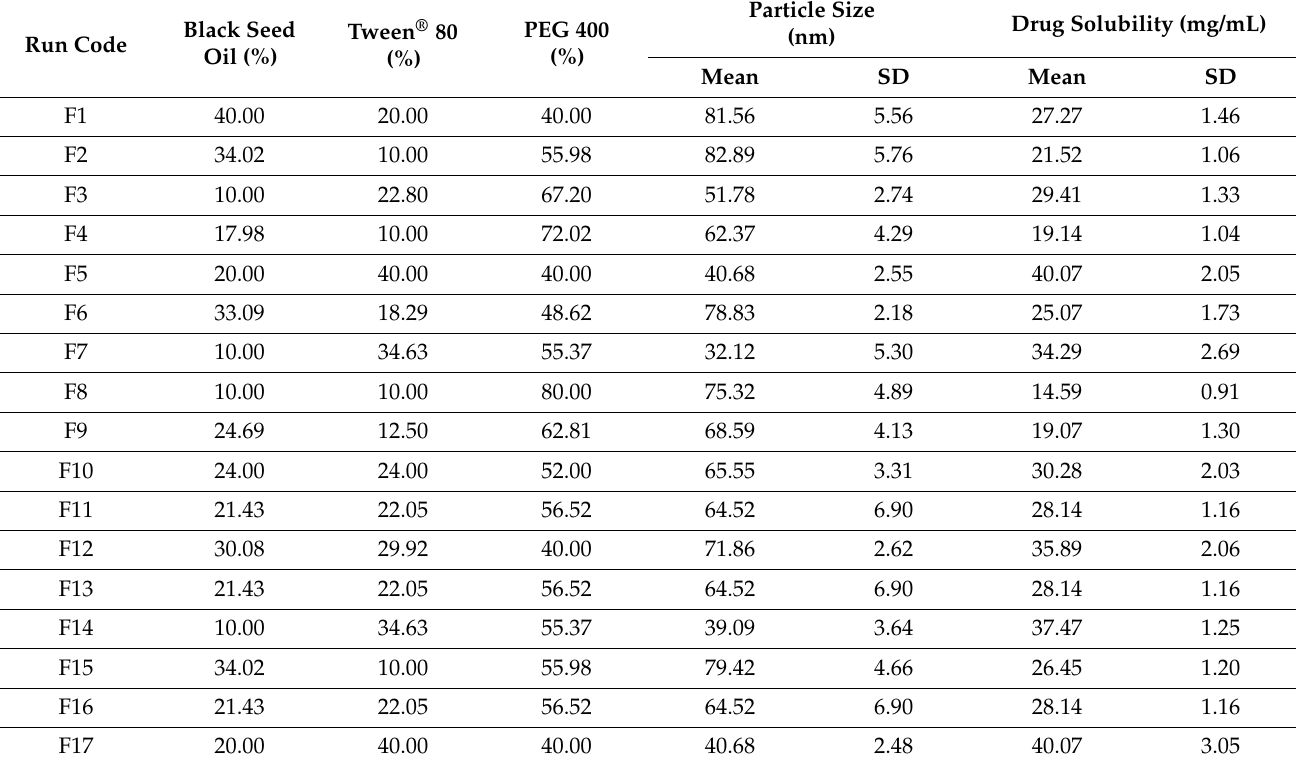
Table 1. Composition and characterization of SNEDDS formulations according to the ternary mixture